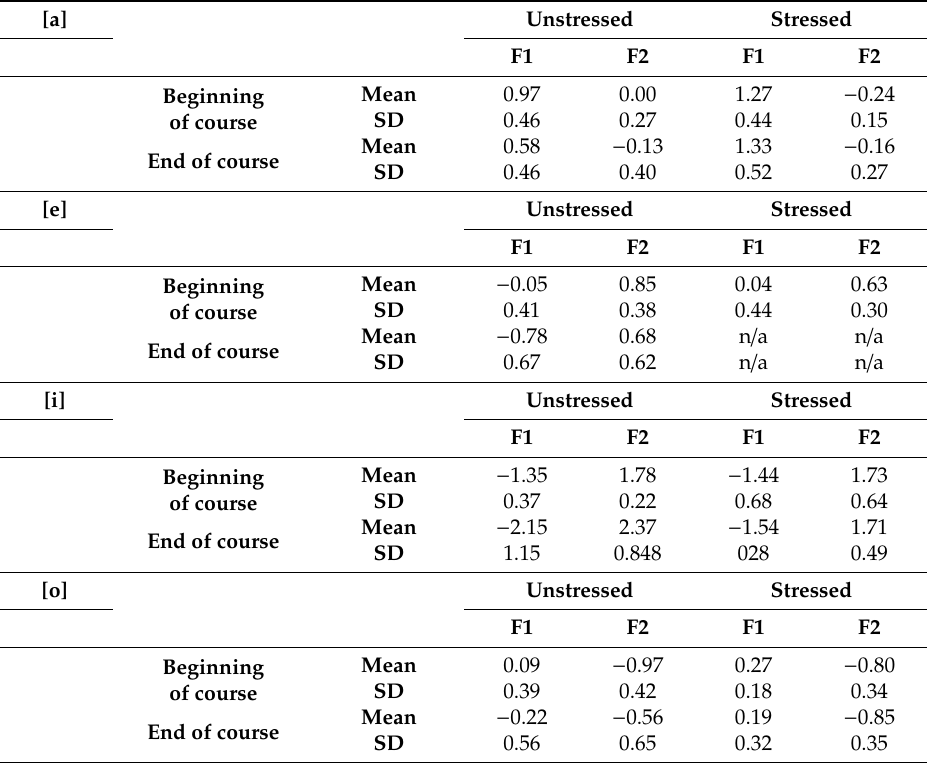
Table 4. Mean Lobanov-normalized F1 and F2 values for Informant B.